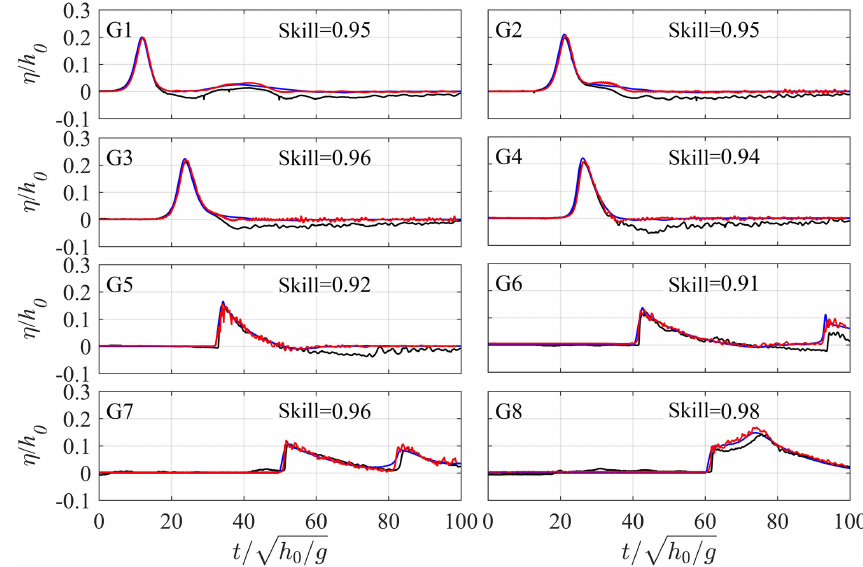
Figure 10. Time series of dimensionless free-surface elevations ( η/h 0 ) at different cross-shore sampling locations (G1–G8) for Scenario 3. Red lines – present simulations; blue lines – simulations from Yao et al. (2008); black lines – measurements from Yao et al. (2008); skill values are for the present simulations.